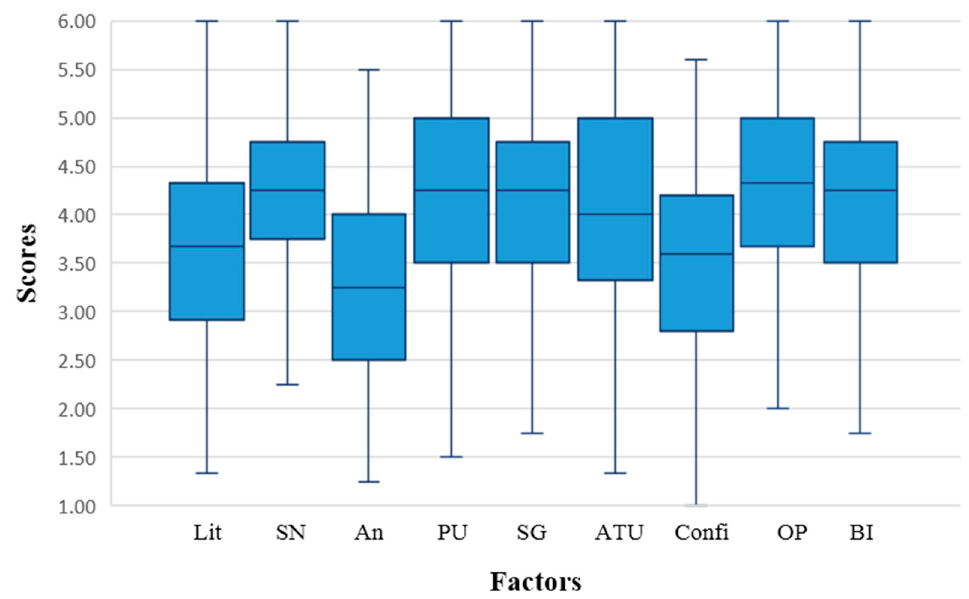
Figure 2. Boxplots for the nine factor scores. Note: Lit: AI literacy; SN: subjective norms; Anx: AI anxiety; PU: perceived usefulness; SG: AI for social good; ATU: attitude towards using AI; Confi: confidence in learning AI; OP: AI optimism; BI: behavioral intention.